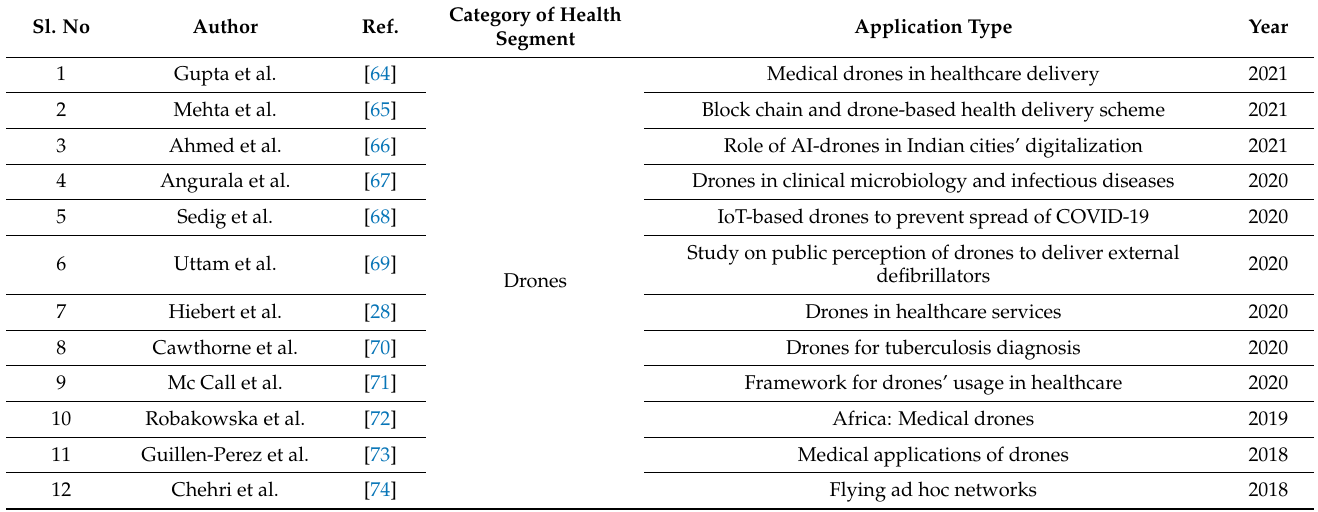
Table 3. Review signifying utility of drones in healthcare